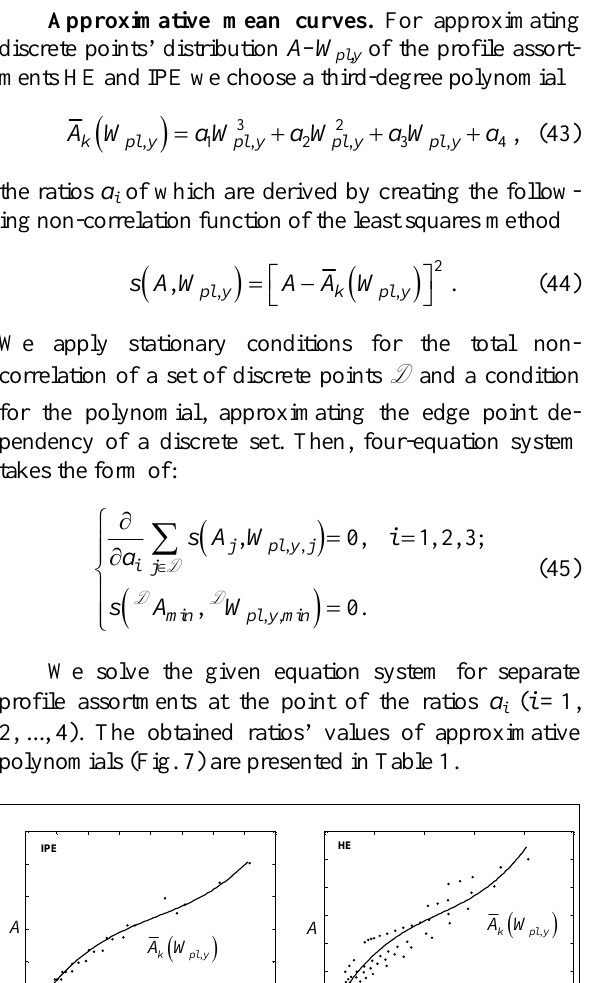
Fig. 6. Fields of discrete values D I-A and admissible I-A characteristics of RHS profile assortment